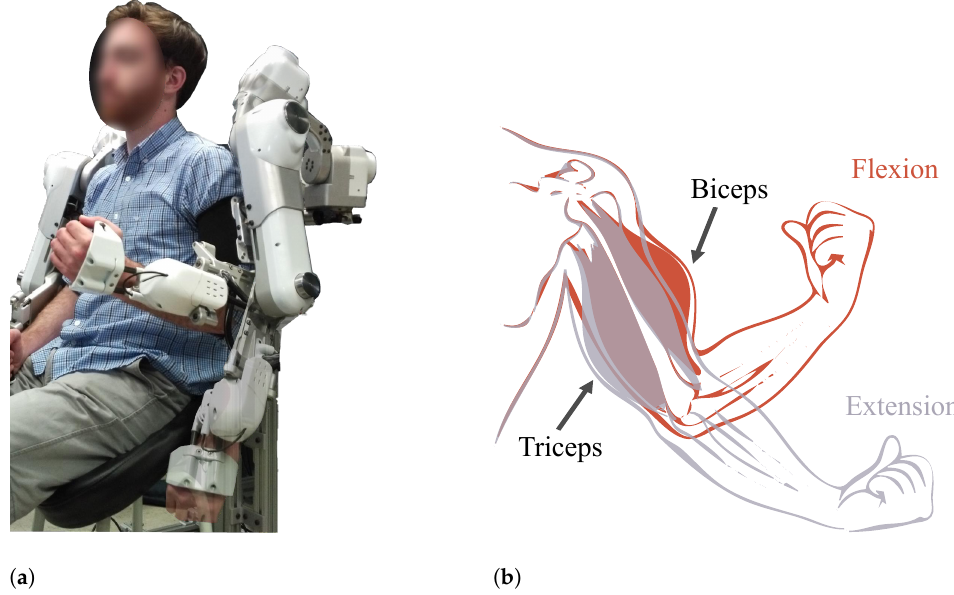
Figure 11. ( a ) Movement performed by the subject starts at full elbow extension (transparent), going to full flexion of the elbow (opaque) and back to full extension at the end of a single repetition. ( b ) Expected deformation of the arm’s muscles in response to the performed movements. Note that panel ( a ) is only a demonstration of the motion and not a representation of the experiment itself. ( a ) Elbow flexion movement in the Harmony exoskeleton. ( b ) Muscle contraction during elbow flexion and extension